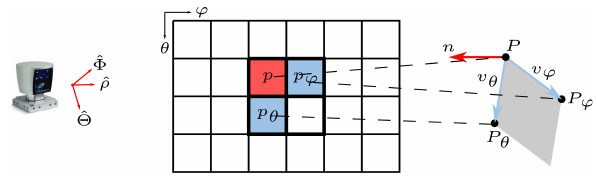
Figure 5. Relationship between adjacent pixels in the radial distance image R and adjacent points in the 3 D space. Pixels p , p ϕ and p θ are associated to 3 D points P , P ϕ and P θ . Since P , P ϕ and P θ compose a local plane, we compute their 3 D gradients as tangent vectors v ϕ , v θ from a radial distance value at p , p ϕ and p θ